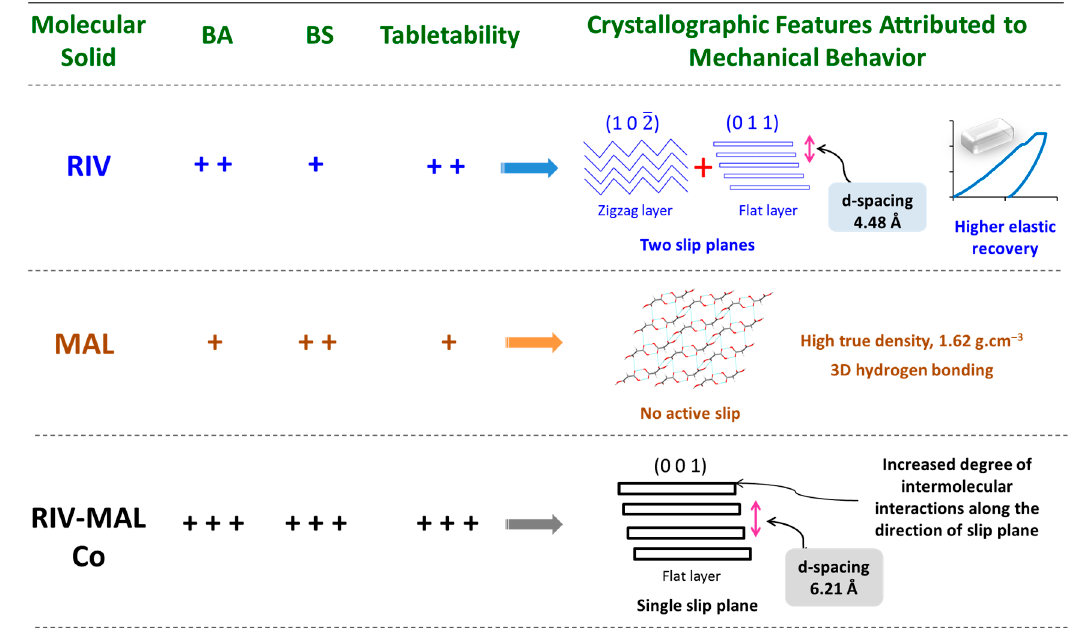
Figure 11. Pictorial depicting a summary of the key findings of present work. The observed values of interparticulate bonding strength (BS), bonding area (BA), and tabletability are expressed in “+” symbol. For the purpose of comparison, “+ + +” indicate “high”; “+” indicate “low”; and “+ +” represents “intermediate” value.